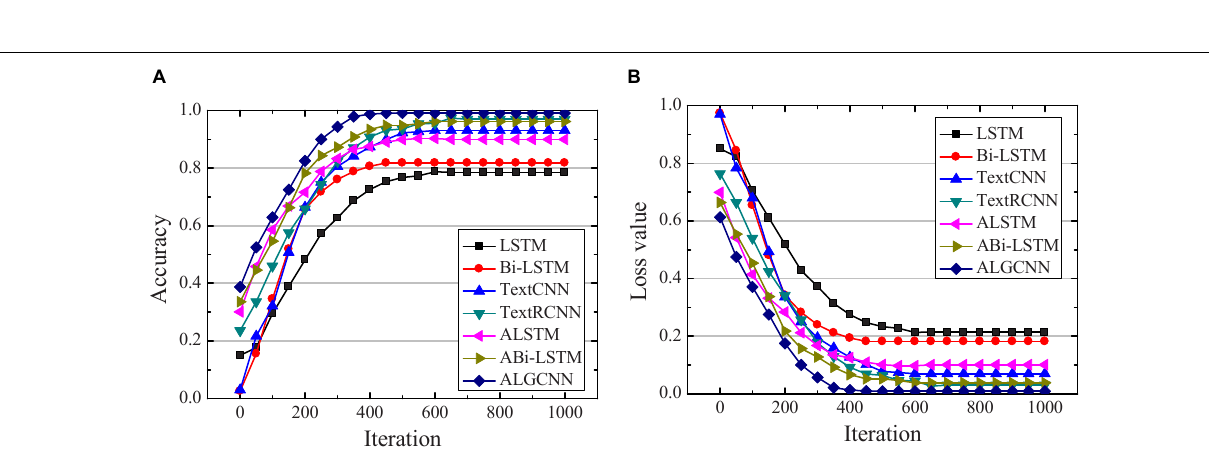
Frontiers in Psychology |